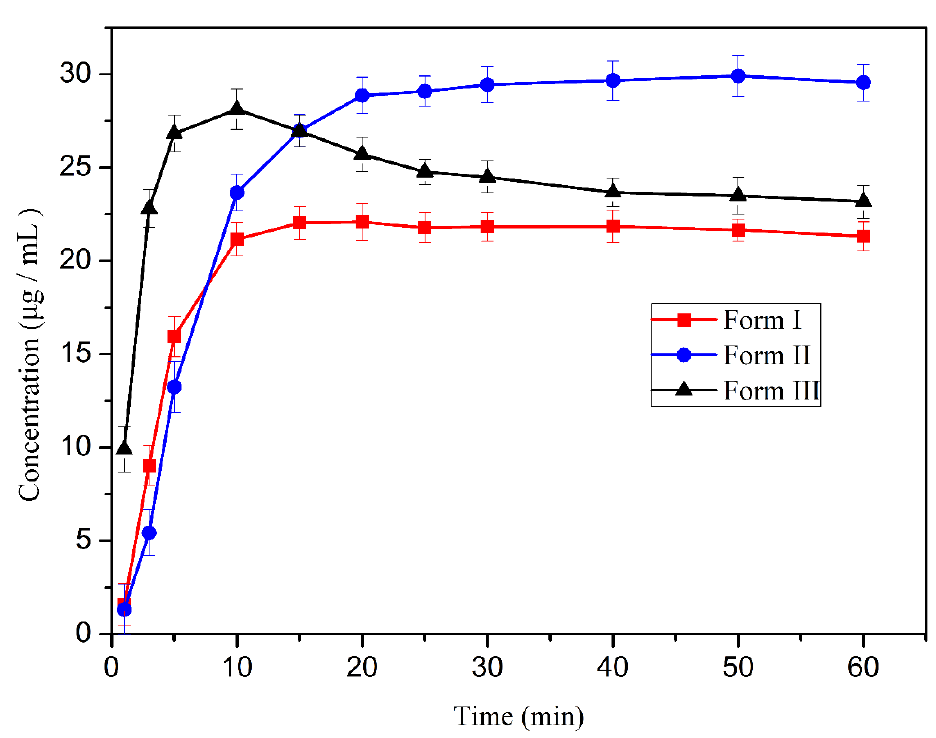
Figure 6. Powder dissolution profiles of BXM Form I, II, and III in pH 1.2 simulated gastric fluids at 37 °C. Data were shown as mean ± SD ( n = 3).